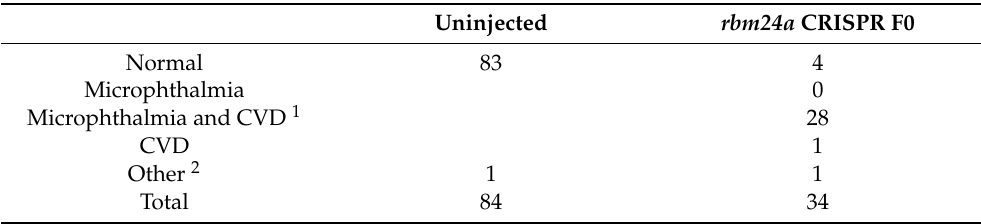
Table 1. Number of phenotypes associated with uninjected control and CRISPR-injected F0